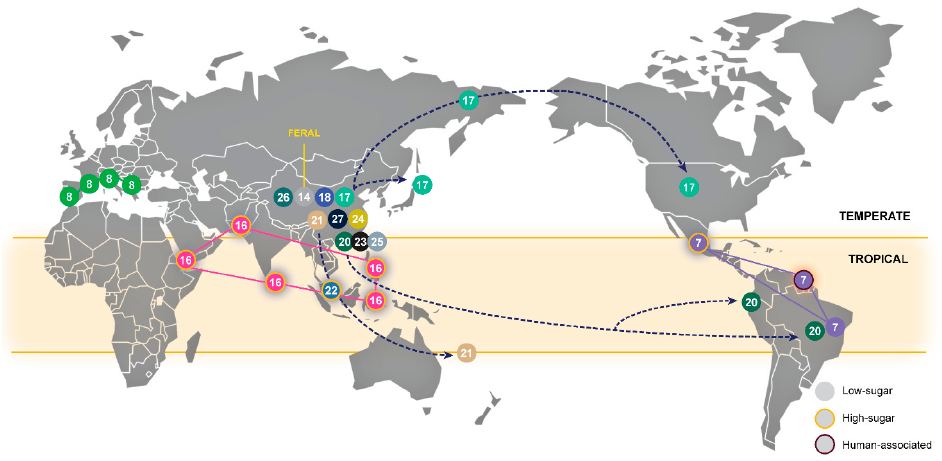
Figure 3. The global biogeography and ecology of wild populations of S. cerevisiae . Populations are numbered and color-coded according to the clades depicted in Figure 1. Circles without outline color correspond to populations associated with low-sugar environments and circles outlined in orange correspond to populations associated with high-sugar environments (in the case of Clade 7, the violet outline color indicates association to the human gut). Possible migration routes are indicated with arrowed dashed lines and population ranges are depicted with solid